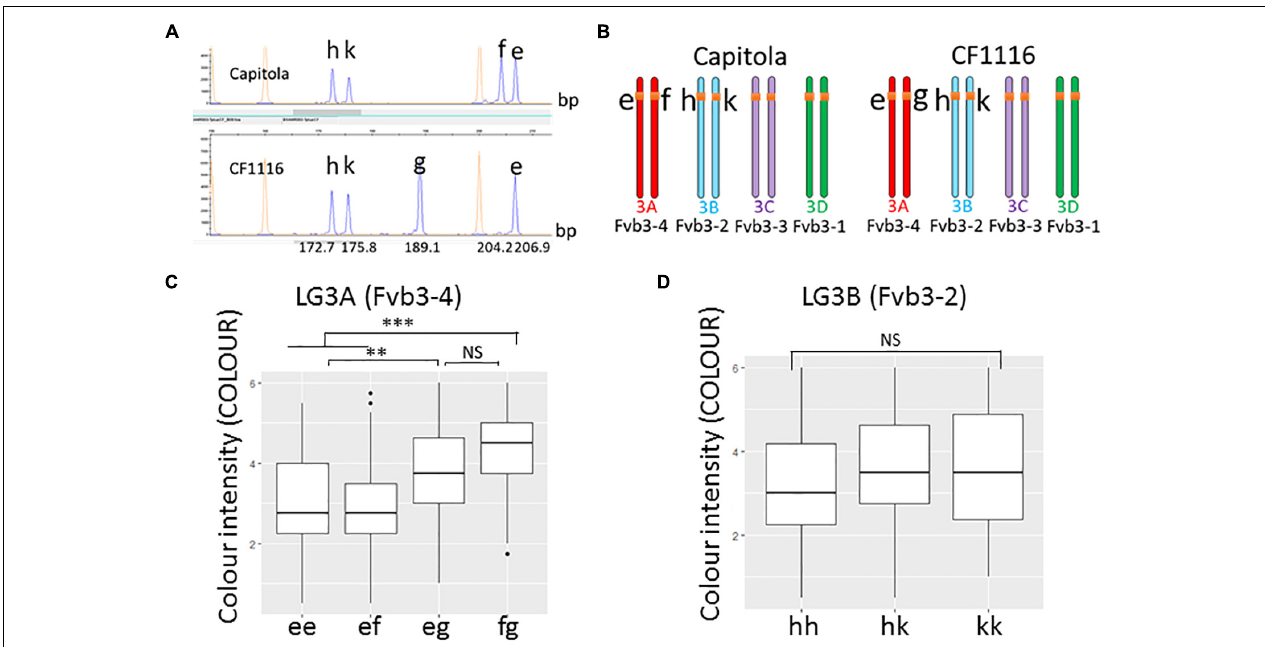
FIGURE 6 | Effect of homoeo-alleles of the BxANR_5UTR marker on fruit colour. (A) Analysis by capillary electrophoresis (ABI 3730) of a PCR-amplified region framing the 18 bp 5 (cid:48) UTR deletion found in ANR led to the identification of five peaks (in blue) corresponding to five homoeo-alleles (h, k, g, f, and e). On LG3A (Fvb3-4), the f allele is only found in “Capitola,” the g allele only in “CF1116” while the e, h, and k homoeo-alleles are found in both “Capitola” and “CF1116.” Estimated fragment sizes of the ANR 5 (cid:48) UTR sequences amplified with M13-tailed primers are indicated on the abscissa. (B) Mapping of ANR homoeo-alleles on homoelogous group 3. (C) Effect of homoeo-alleles e, f, and g on colour intensity. The allelic status of individuals is indicated on the abscissa. (D) Effect of homoeo-alleles h and k on colour intensity. The allelic status of individual is indicated on the abscissa. Colour intensity was evaluated on a scale from 0 (very pale red-orange) to 6 (very dark red). Boxes represent the trait variation of individuals with the reported combination of alleles. Kruskal–Wallis test: ∗∗ P < 0.01; ∗∗∗ P < 0.001; NS, not